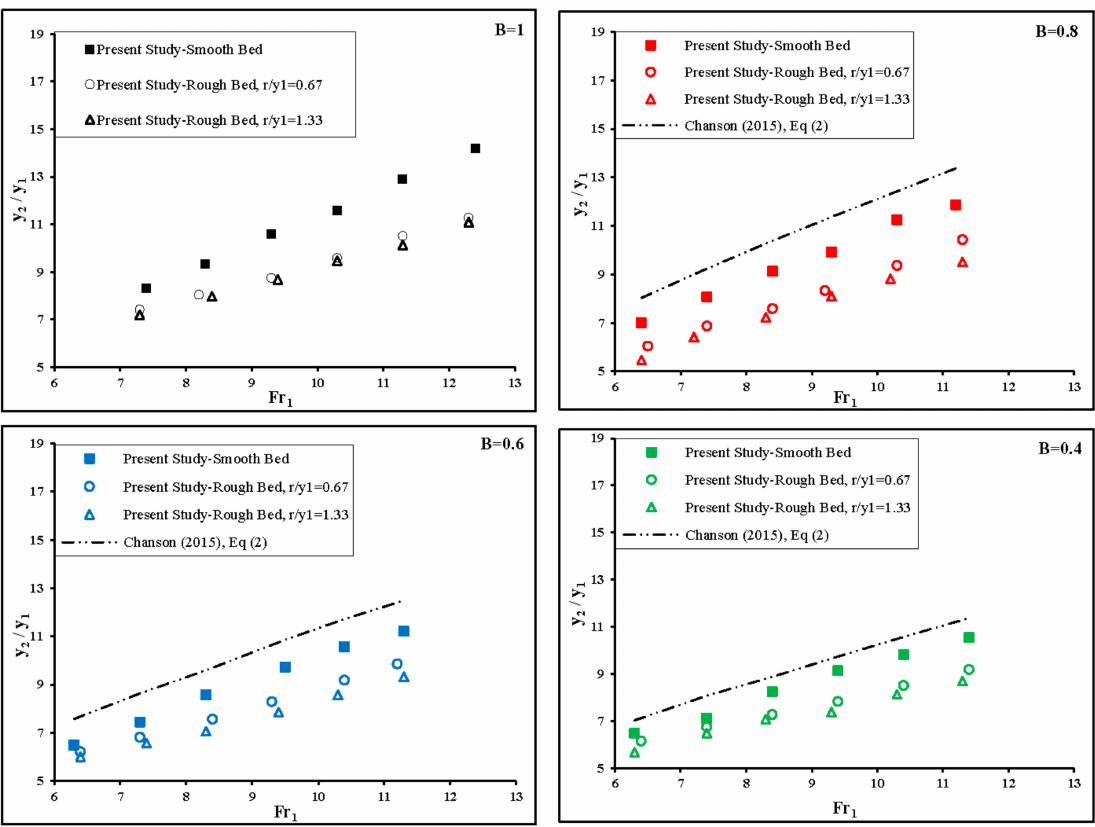
Figure 4. Variation of the sequent depth ratio vs. the inflow Froude number for two relative height of roughness elements ( r / y 1 = 0.67 and r / y 1 = 1.33) and different divergence ratio ( B = 1, 0.8, 0.6,